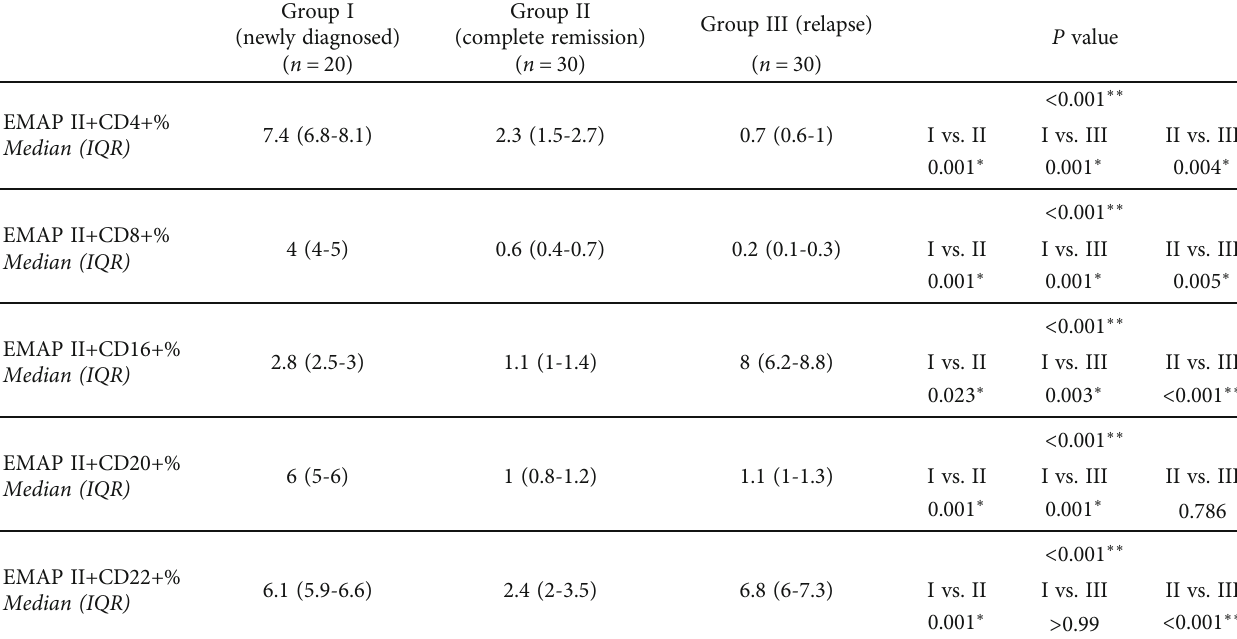
Table 2: Percentage of EMAP II in peripheral blood cells in non-Hodgkin ’ s lymphoma (NHL)